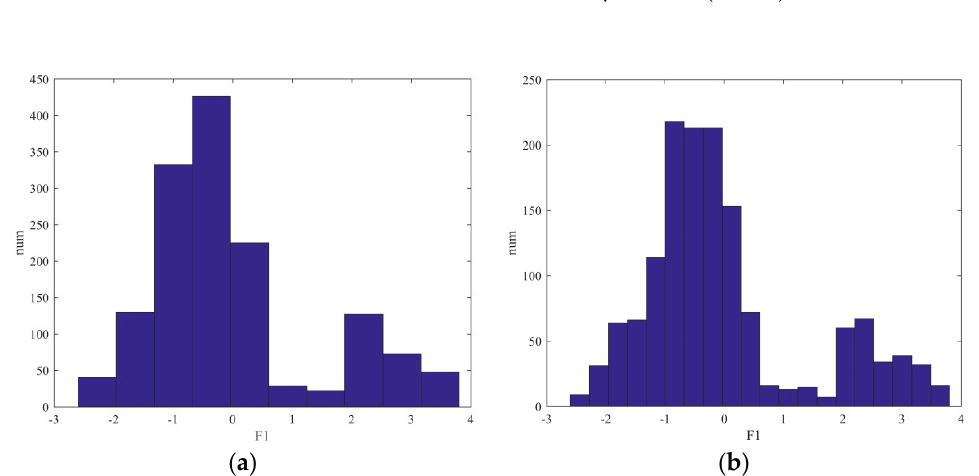
Figure 5. Histograms of point density distribution with different statistical interval. ( a ) Statistical interval is 0.6; ( b ) Statistical interval is 0.3.